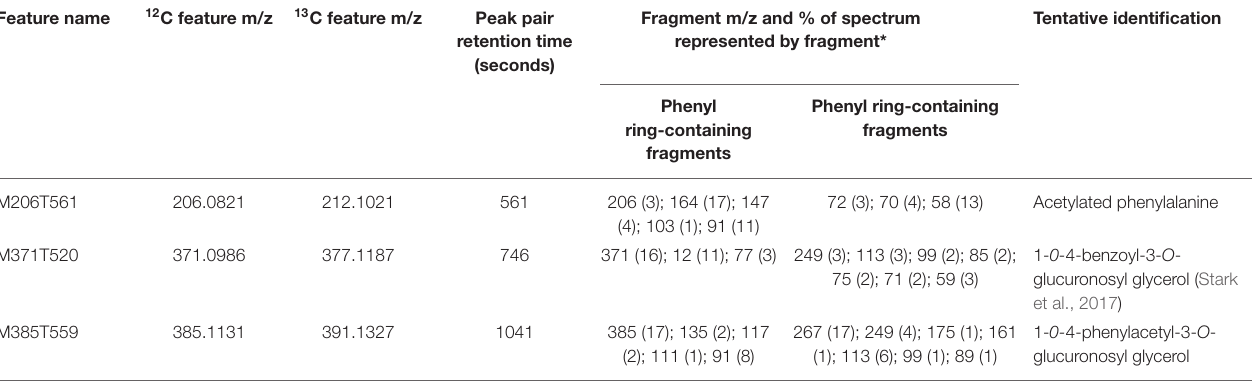
TABLE 3 | Phe-Derived metabolites and their MS/MS fragmentation ratios. Feature